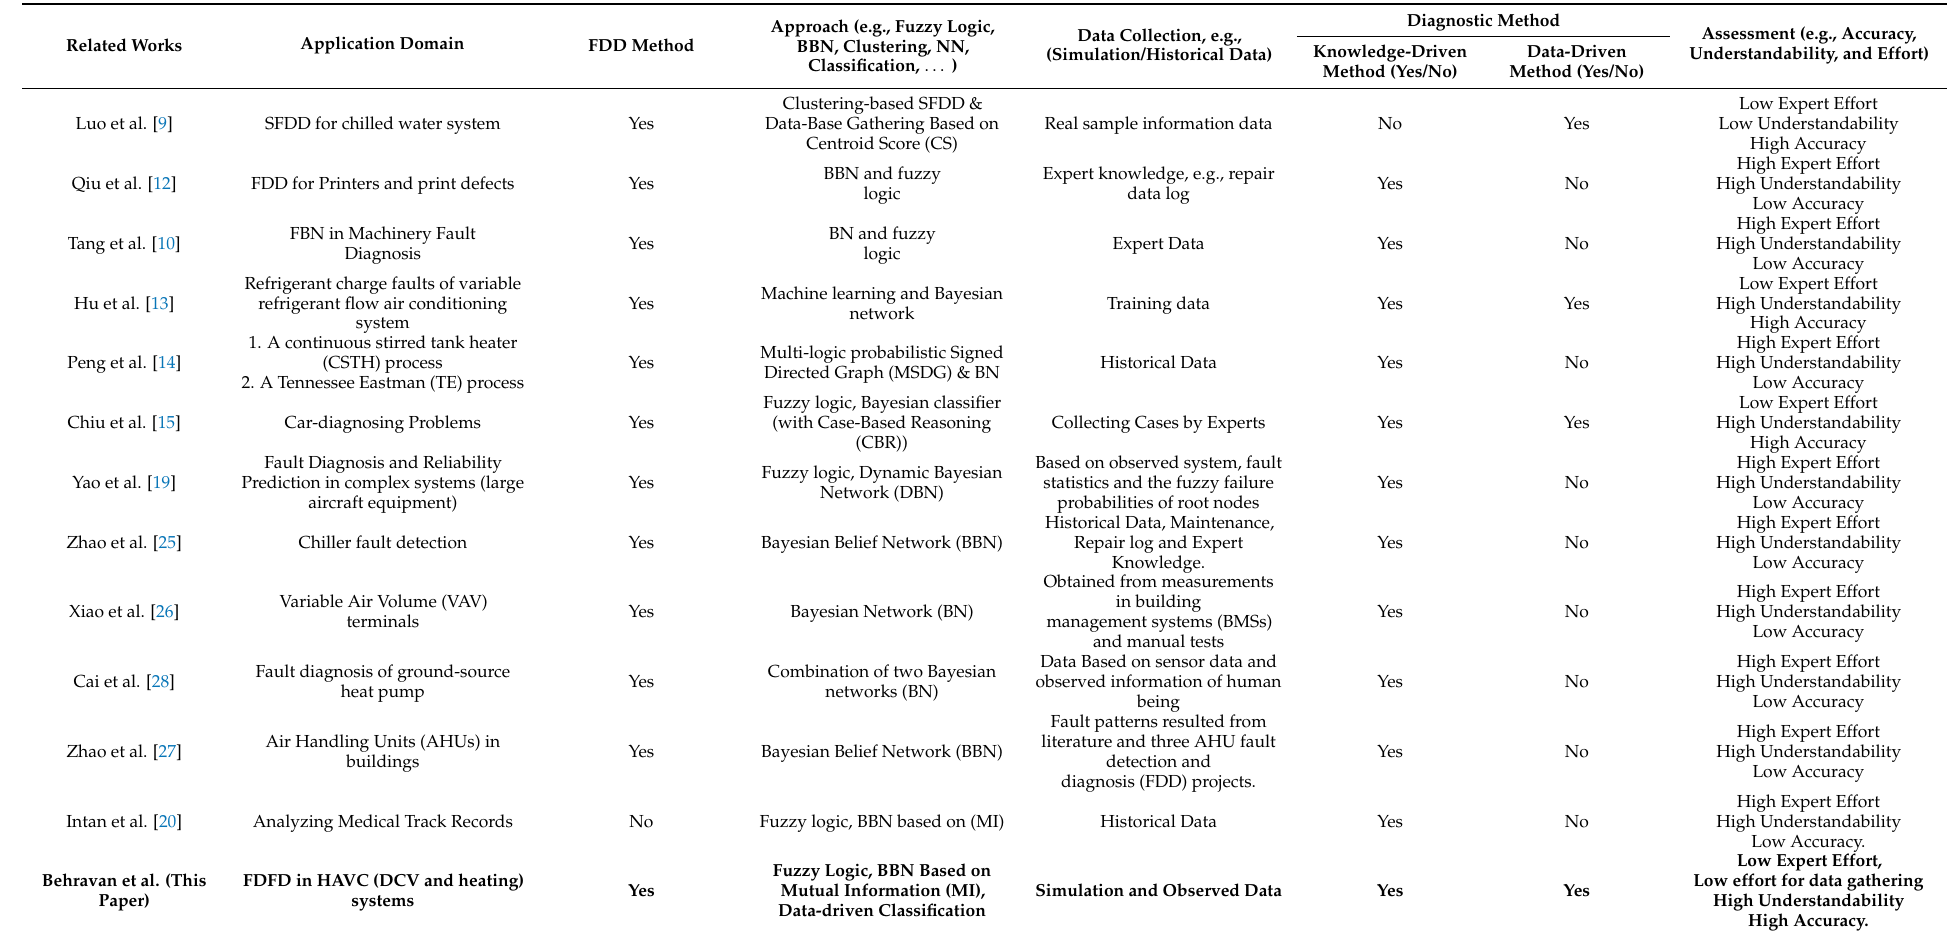
Table 1. Overview of the related